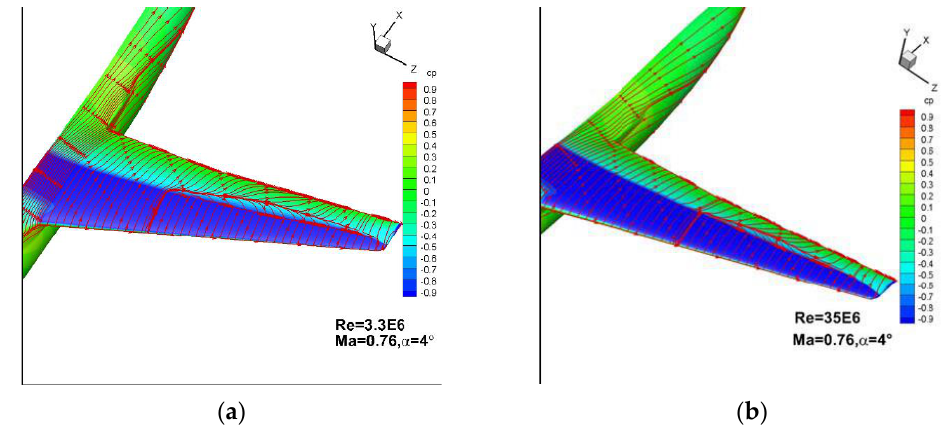
Figure 13 . Numerical flow structures at different Reynolds numbers (M = 0.76, α = 4°): ( a ) Re = 3.3 × 10 6 ; ( b ) Re = 35 × 10 6 . Figure 13. Numerical flow structures at different Reynolds numbers (M = 0.76, α = 4 ◦ ): ( a ) Re = 3.3 × 10 6 ; ( b ) Re = 35 × 10 6